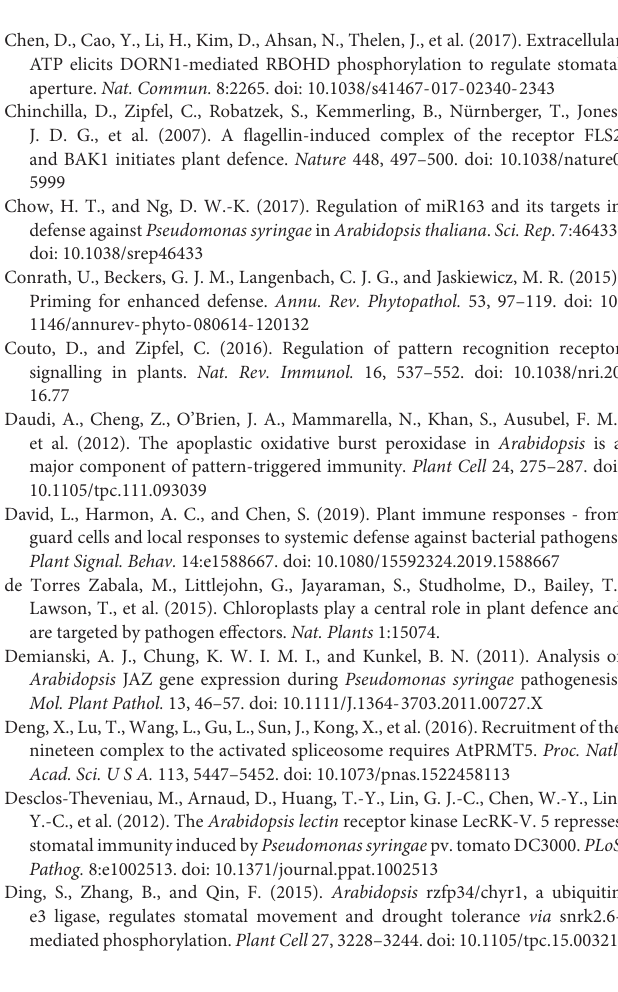
Supplementary Figure 12 | Stomatal closure following ABA treatment in Col-0 and smd3b-1 . Mean values ( ± SEM) were obtained from six independent experiments with 40 stomata per data point; letters represent significant difference ( P < 0.05) for Tukey’s HSD test. Supplementary Figure 13 | Pst infection changes the level of pri-miRNAs in the smd3b-1 mutant. RT-qPCR analysis of chosen pri-miRNAs during Pst infection. Samples were collected from 6-week-old control (MgCl 2 ) and infected (48 hpi, Pst ) Col-0 and smd3b-1 plants. Results represent mean of three independent biological replicates with error bars showing SD with no statistically significant changes. GAPDH mRNA was used as a reference. Supplementary Table 1 | Characteristics of genes involved in pathogen response having significantly affected alternative splicing events in the smd3b-1 plants. Supplementary Table 2 | List of primers used in this study. Supplementary Dataset 1 | List of significantly affected genes based on RNA-seq. Supplementary Dataset 2 | Significantly enriched Gene Ontology terms among different gene sets. Supplementary Dataset 3 | List of genes involved in different aspect of pathogen response with significantly changed expression in the smd3b-1 mutant. Supplementary Dataset 4 | List of alternative splicing